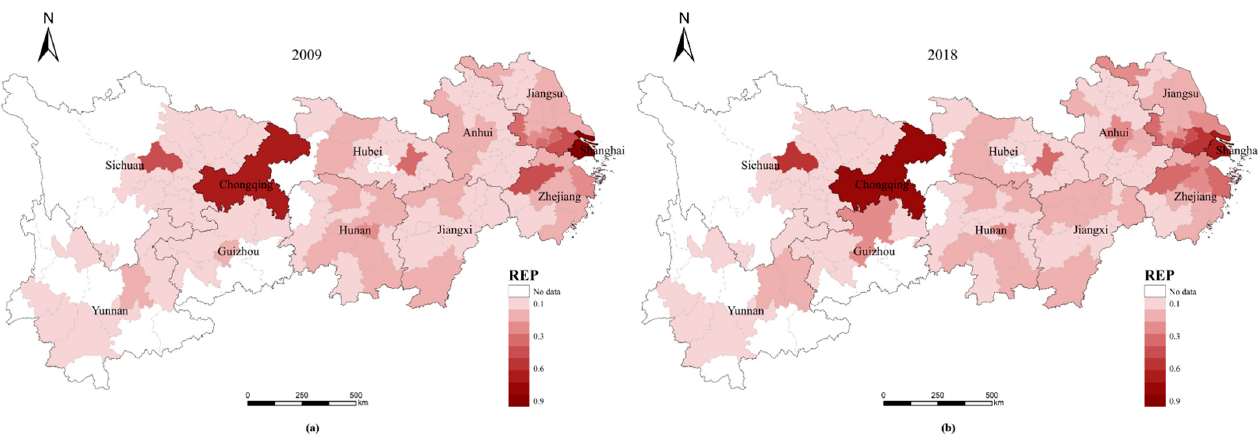
Figure 4. The spatial distribution of the REP index for cities in YREB in 2009 and 2018.